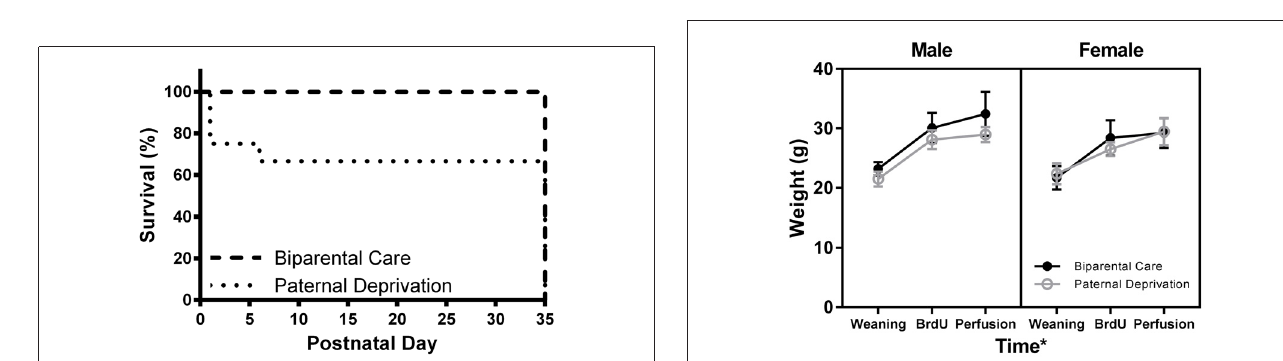
time of BrdU injection and at perfusion. Symbols represent mean ± SEM. ∗ , main effect of time, p ≤